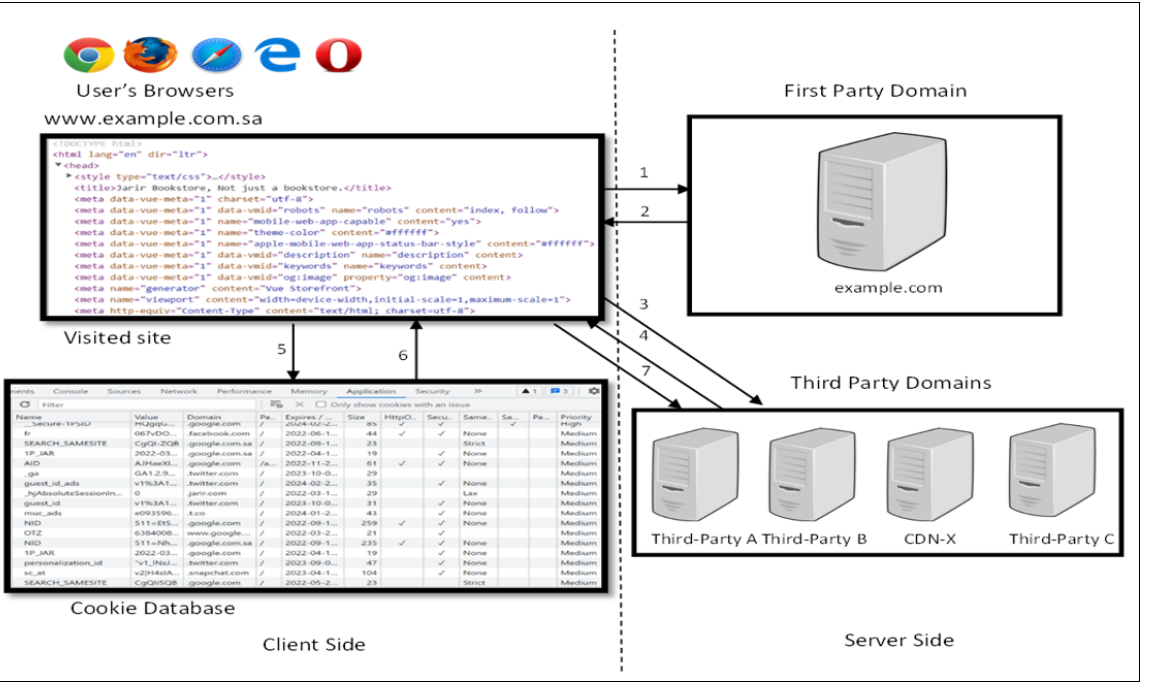
Figure 1. The process of tracking the web page and rendering it through the execution of JavaScript programs. Examples.com uses third-party servers (A, B, CDN-X, and C) looking for additional content and analytics